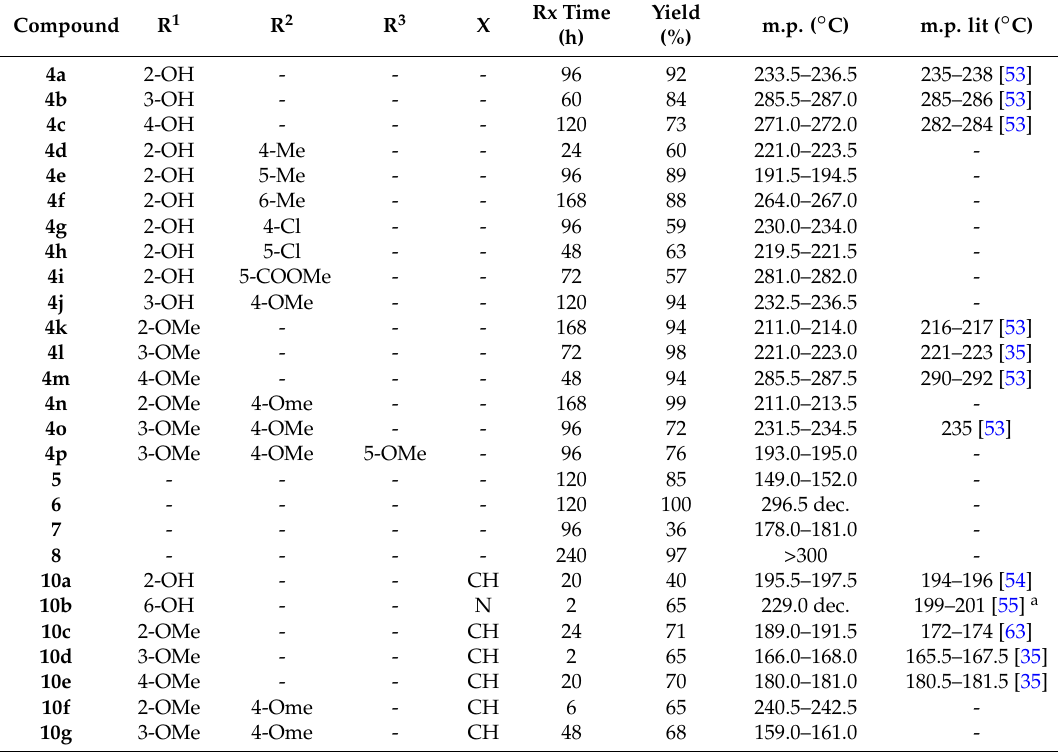
Table 1. Characteristics of compounds 4a – p , 5 – 8 , and 10a – g